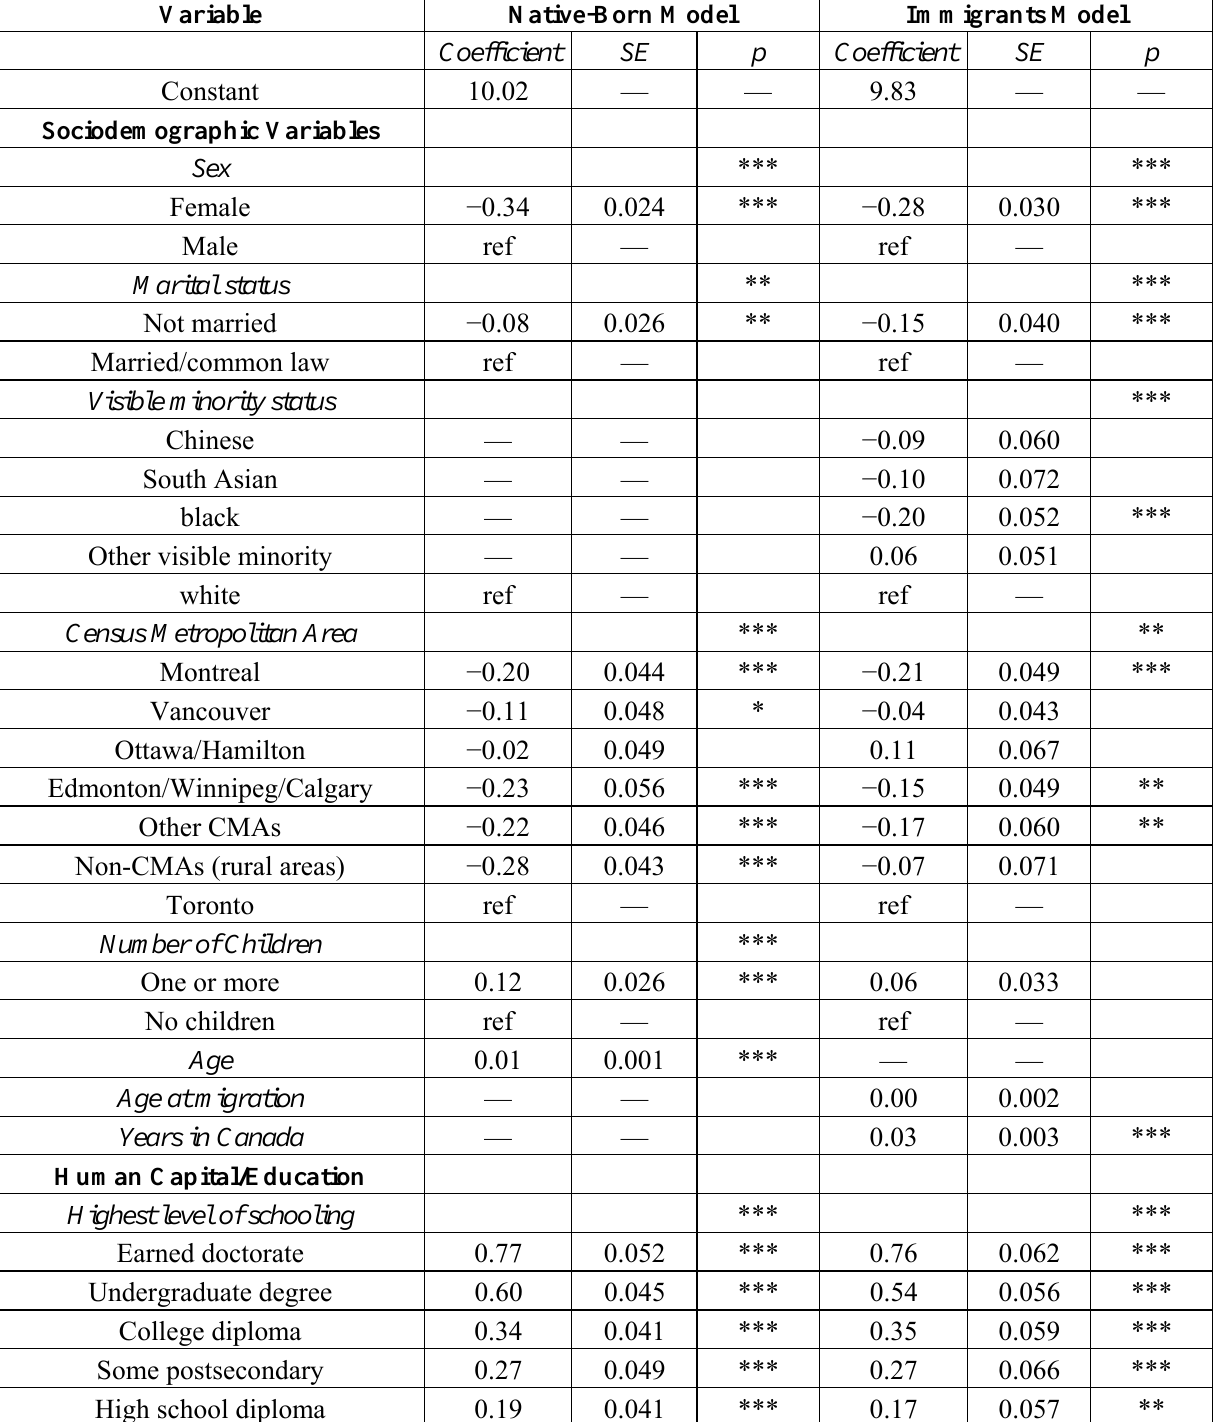
Table 2. Estimates from ordinary least squares (OLS) models predicting log earnings from the independent